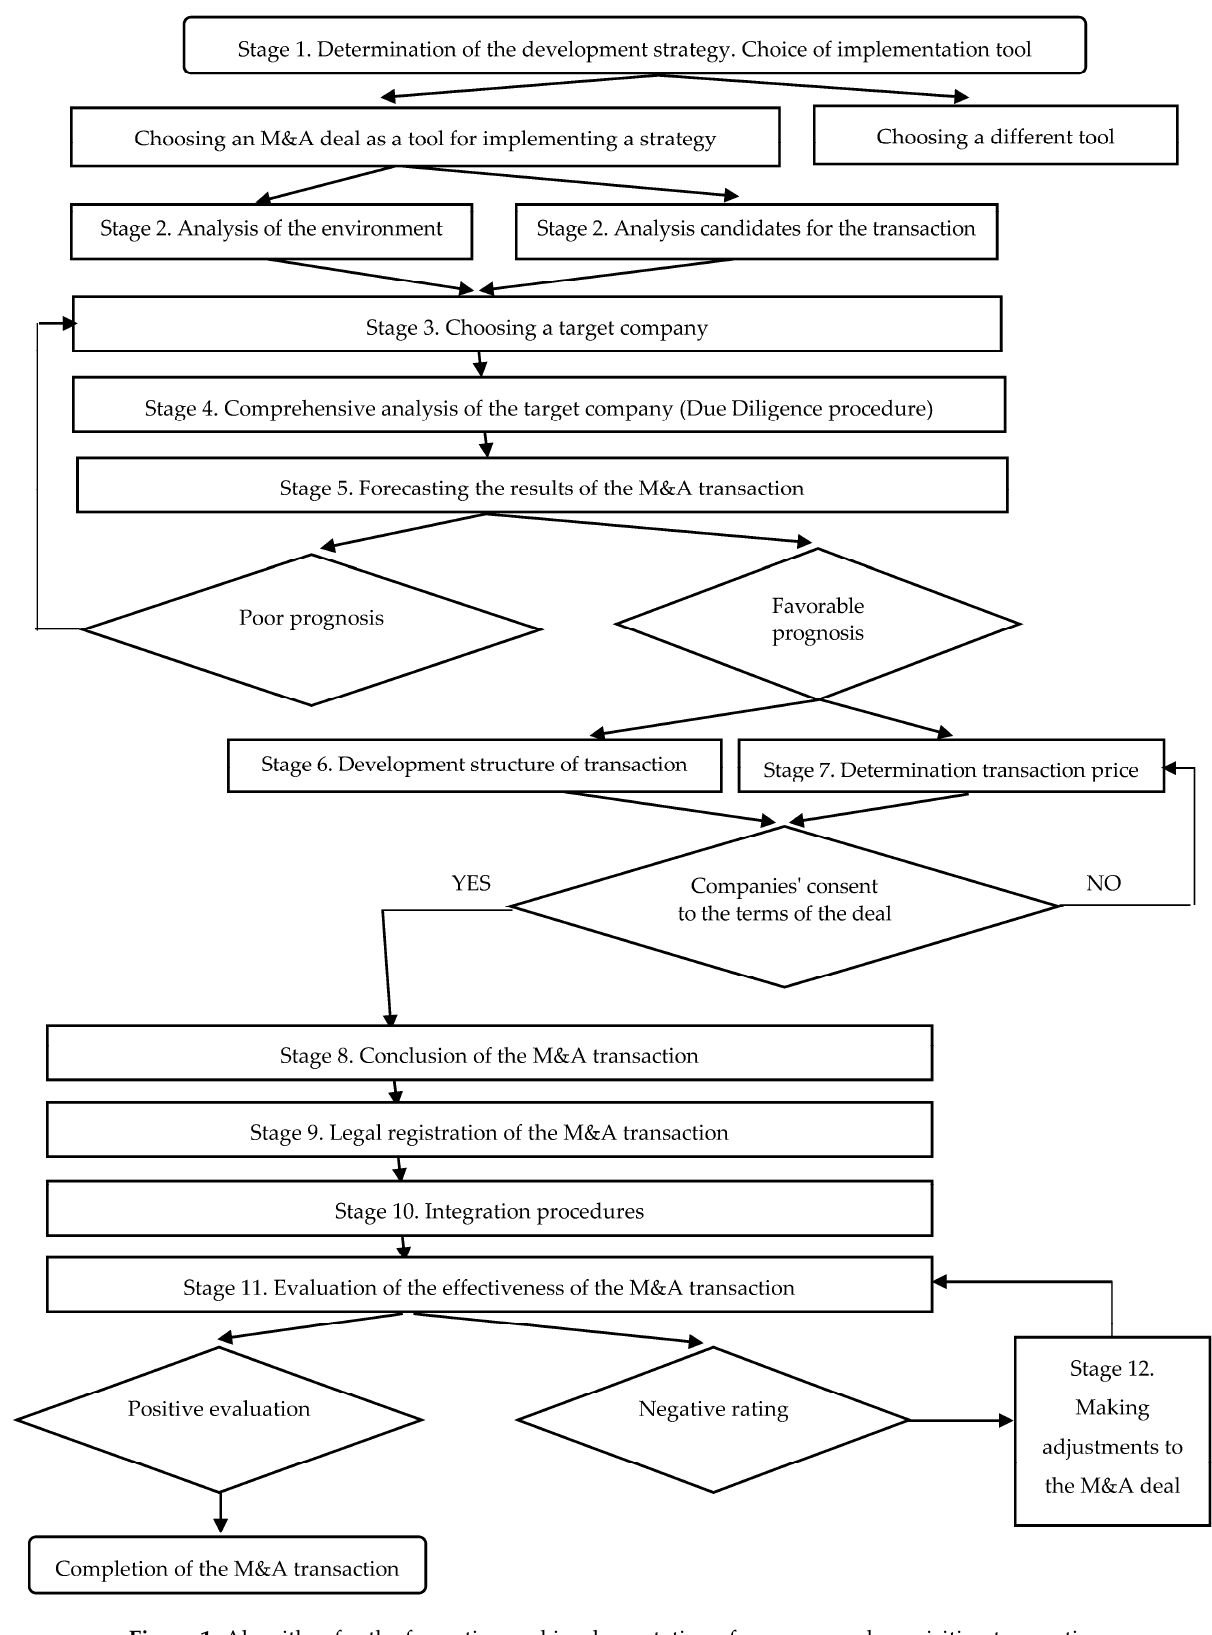
Figure 1. Algorithm for the formation and implementation of a merger and acquisition transaction.